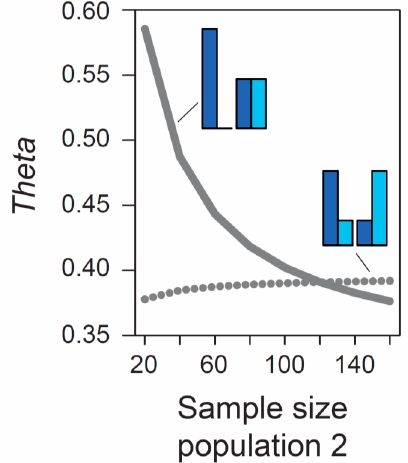
Figure 2. Influence of sample size imbalance between populations on the magnitude of the F ST estimator Theta at a single SNP. Sample size for population 1 is always 40 nucleotides, as in Figure 1, but sample size for population 2 varies from 20 to 160 nucleotides (X-axis). Two di ff erent MAF levels are considered (minimal, solid line; maximal, dotted line). Sampling occurs deterministically at the exact population allele frequencies illustrated by the bar plots. For both MAF levels and across the full parameter range considered, the magnitude of allele frequency di ff erentiation between the populations is therefore invariably perfectly intermediate ( AFD is 0.5